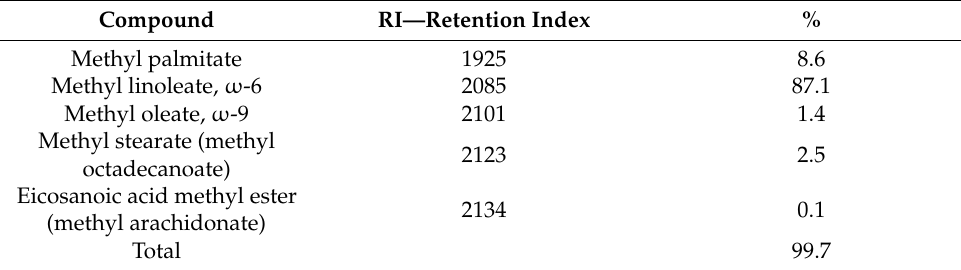
Table 3. Fatty acid composition of black mulberry seed oil